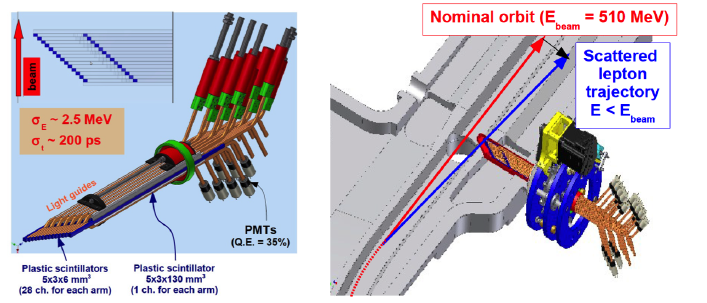
Figure 3. Scheme of a HET station: scintillator hodoscope (left); positioning in the DA Φ NE beam-pipe